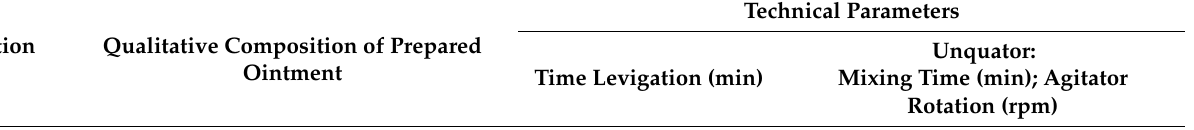
Table 1. The composition of suspension-type ointments with benzocaine and technical parameters of their preparation